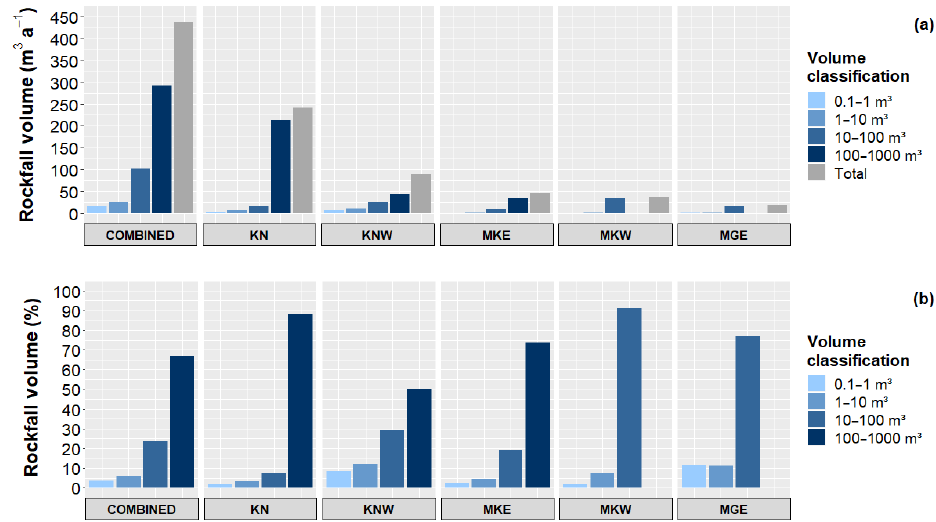
Figure 3. (a) Absolute rockfall volume (m 3 a − 1 ) and (b) relative rockfall volume (%) for all monitored rockwalls. About two-thirds (67%) of the total rockfall volume fall into the largest size class (100–1000m 3 ), reflecting the dominance of large events.